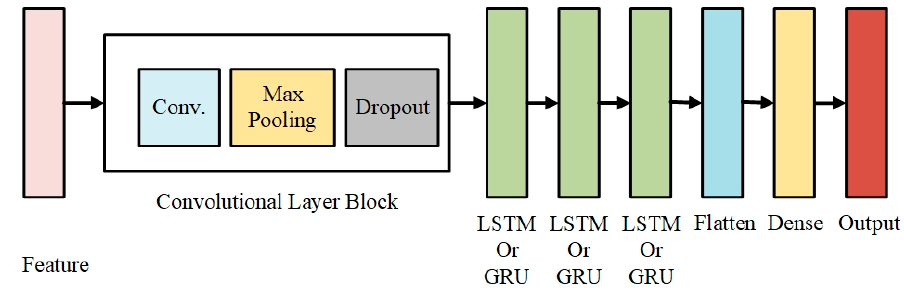
Figure 8. Proposed CNN and variants of RNN (LSTM/GRU).